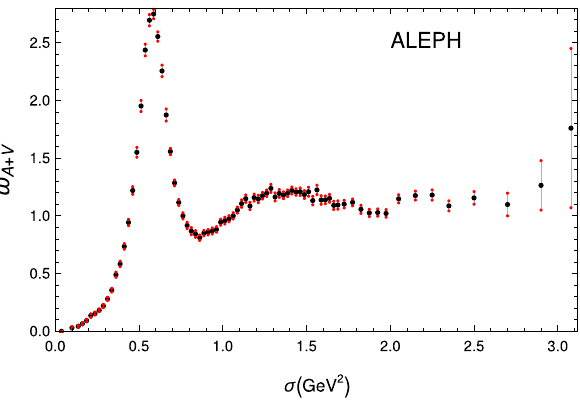
Fig. 1 The closed contour C 1 + C 2 for integration of g ( Q 2 )(cid:10)( Q 2 ) , where the contour radius is R = σ max ( ≡ σ m ) ( ≤ m 2 τ )